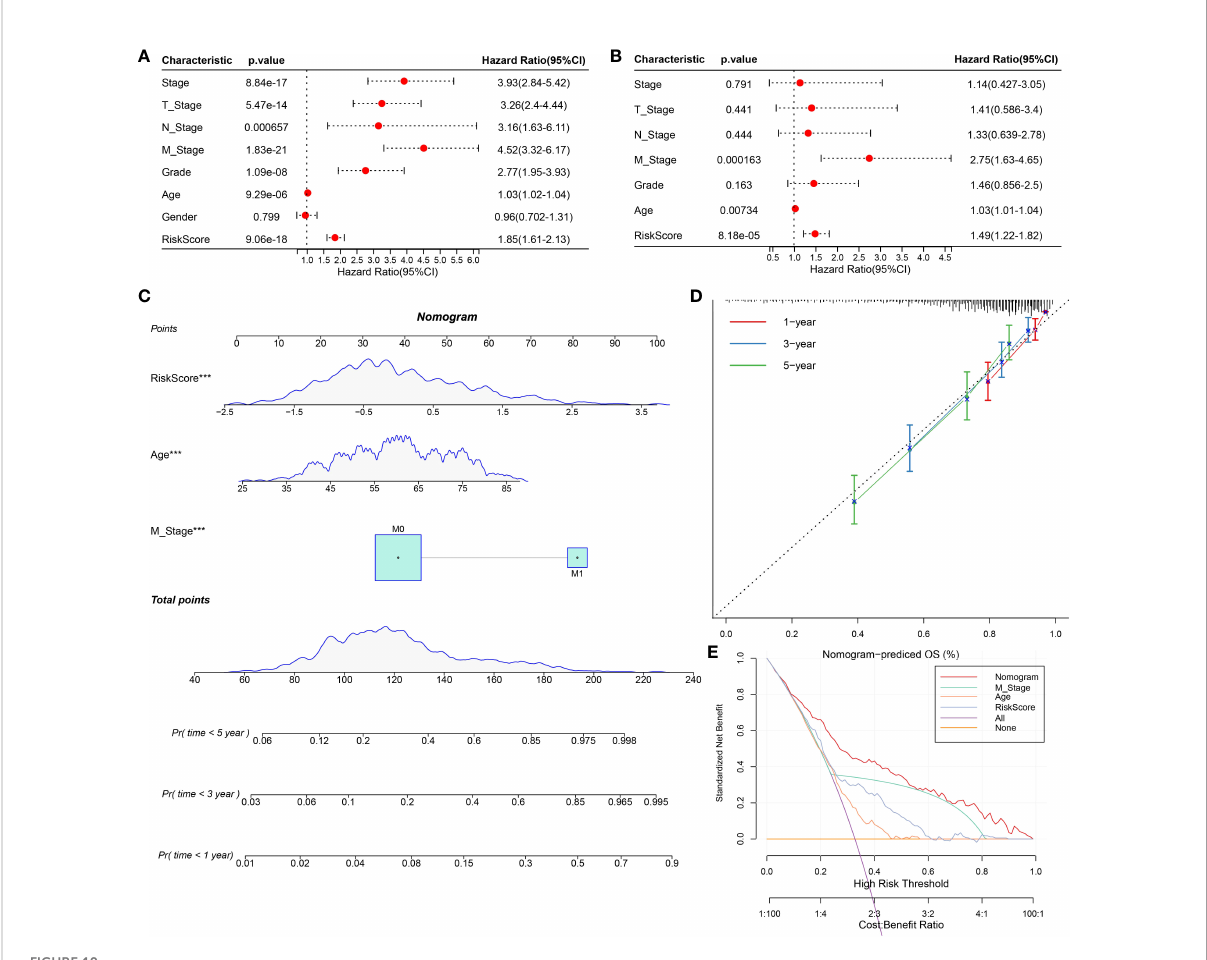
FIGURE 10 Construction and evaluation of nomogram based on independent prognostic indicators of ccRCC. (A, B) Univariate and multivariate Cox regression analyses screened the independent prognostic indicators of ccRCC from the clinical features of ccRCC and risk score. (C) Construction of a nomogram in conjunction with variables that independently predict ccRCC prognosis. (D) The calibration plot of the nomogram. (E) Decision curve analysis for ccRCC prognosis-related index and